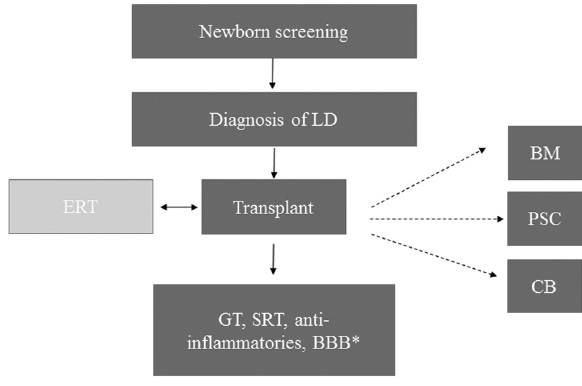
Figure 2 - Tentative workflow for HSCT combined with newborn screen- ing. After diagnosis of LDs, patients can receive a transplant as early as two weeks of age. ERT may start prior to the transplant and can be contin- ued for the first few months until full chimerism is achieved. HSCT can also be combined with gene therapy, substrate reduction therapy, anti- inflammatories, and molecules that increase blood-brain barrier perme- ability to improve clinical outcomes. LD: lysosomal disorder; ERT: en- zyme replacement therapy; BM: bone marrow; PSC: peripheral stem cell; CB: cord blood; GT: gene therapy; SRT: substrate reduction therapy; BBB: blood brain barrier; BBB*: molecules that increase BBB permeabil-